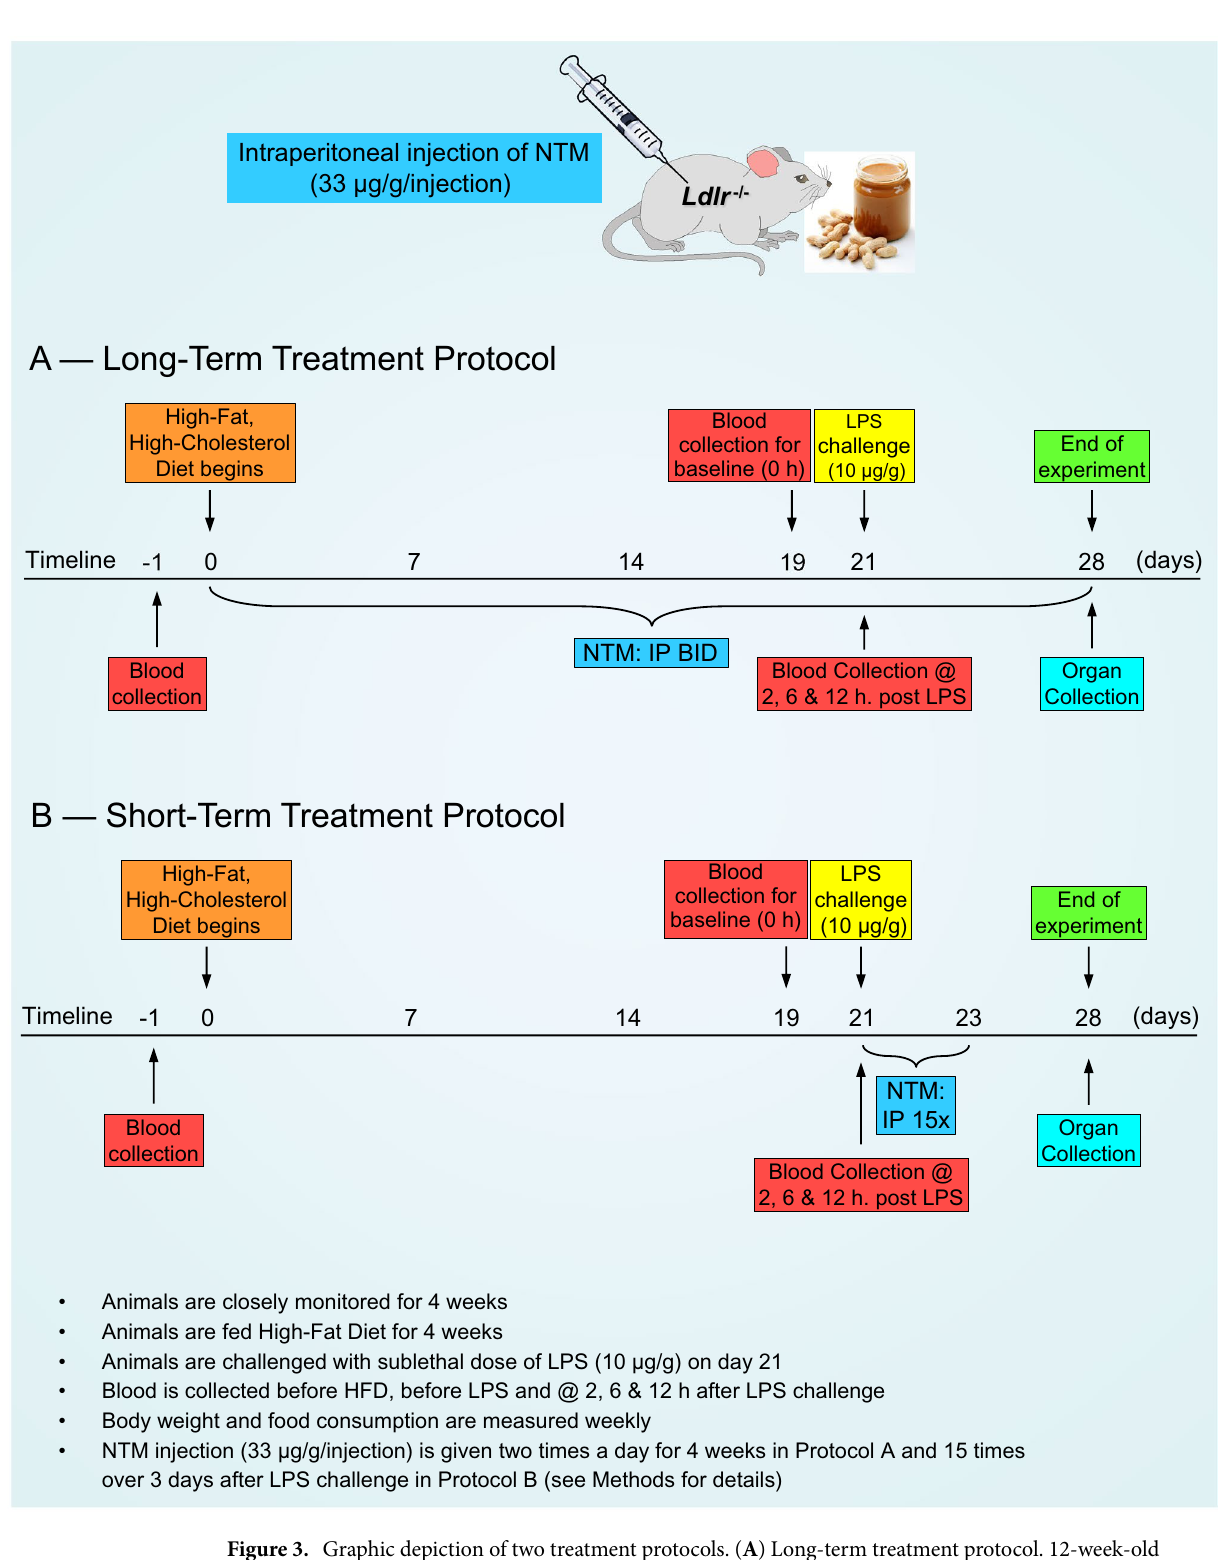
Figure 3. Graphic depiction of two treatment protocols. ( A ) Long-term treatment protocol. 12-week-old ldlr −/− female mice were placed on HFD and treated with saline (IP, twice a day (BID), 0.2 mL) or NTM peptides (IP, BID, 33 μg/g in 0.2 mL saline) for three weeks before non-lethal dose of LPS (10 μg/g in 0.2 mL saline) was administered through IP injection. HFD feeding and treatment with saline or NTM were continued for additional week. ( B ) Short-term treatment protocol. 15-week-old ldlr −/− female mice fed HFD for three weeks were challenged with a non-lethal dose of LPS (10 μg/g in 0.2 mL saline, IP) and threated with 15 doses of saline (0.2 mL) or NTM peptides (IP, 33 μg/g in 0.2 mL saline) given 30 min before LPS challenge (10 μg/g in 0.2 mL saline) and for three days thereafter. HFD feeding continued for another